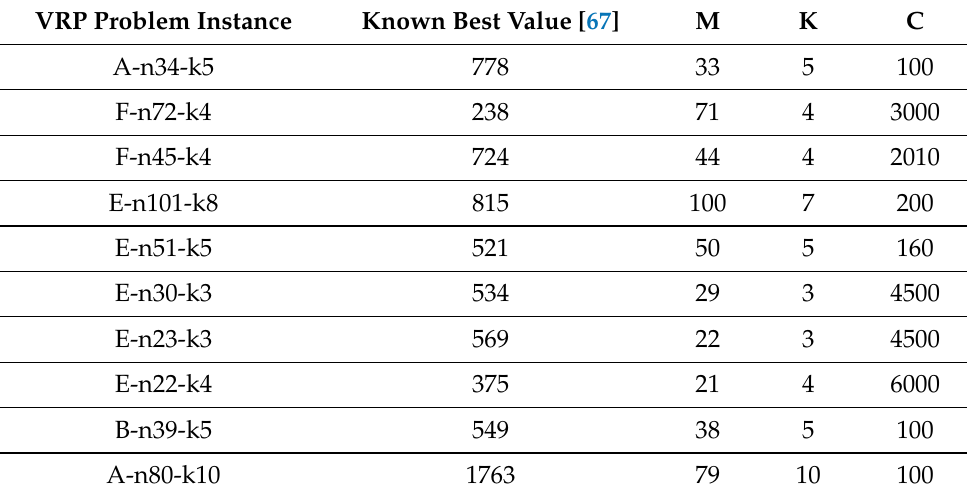
Table 3. VRP instances for BDPP